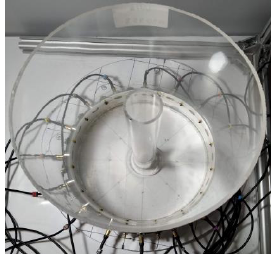
Figure 3. The developed 64-channel reflective ultrasound tomography.